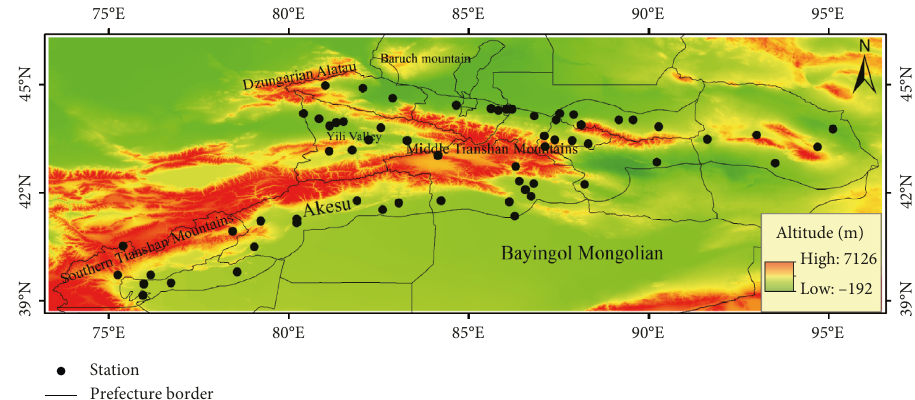
Figure 1: Study area and distribution of weather stations ( • represent national meteorological stations). Table 1: Statistics of the M α CS occurrences during 2005–2015. Case no.